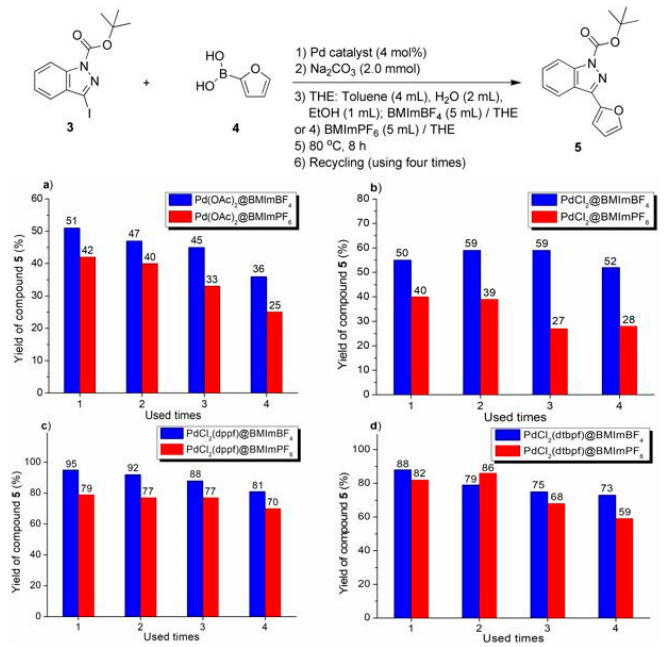
Figure 2. Recycling experiments on Suzuki–Miyaura cross-coupling of compounds 3 with 4 catalyzed by Pd catalyst, immobilized over imidazolium ionic liquid: ( a ) Pd(OAc) 2 over ILs; ( b ) PdCl 2 over ILs; ( c ) PdCl 2 (dppf) over ILs; ( d ) PdCl 2 (dtbpf) over ILs.